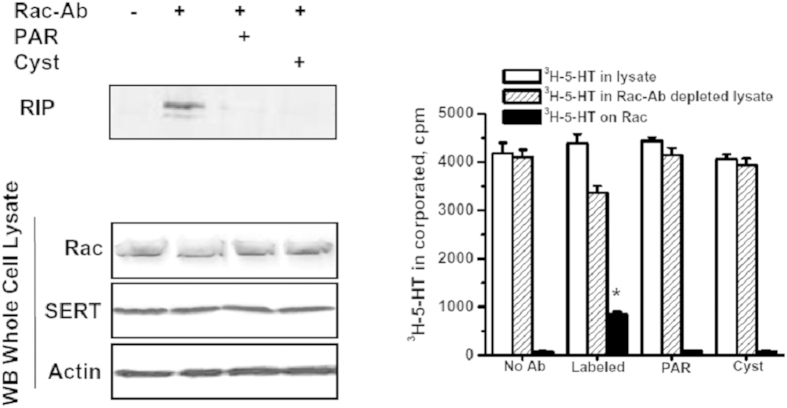
RIP of 3H-5HT labeled Rac.Endothelial cells are treated with 20 mM 5-HT alone (lane 2) or 20 min after PAR (lane 3) or Cyst (lane 4) treatments. At the end of incubation time [3H]-5HT was included in PBS/CM at room temperature. After 1 hr, cells were washed with ice cold PBS and harvested. Samples from: (i) whole cell lysate; (ii) the proteins pulled down by Rac-Ab; and (iii) depleted cell lysates after Rac-Ab pull were normalized based on their protein concentration. Then, equal amount of samples from each group were mixed with 5 ml scintillation cocktail and measured in the scintillation counter (bar graph). Immune precipitates were eluted from the beads by incubation in SDS sample buffer, analyzed by 12.5% SDS-PAGE, and Rac was visualized by fluorography. A 25 kD major band representing Rac was precipitated with anti-Rac Ab only from the cells of 5-HT-treated. PAR- or Cyst-treatment inhibits the serotonylation of Rac. The whole cell expression of SERT and Rac were determined by WB of endothelial cells, which shows that PAR or Cyst treatment did not change the level of SERT or Rac. Data are representative of at least three independent experiments (mean ± SD).